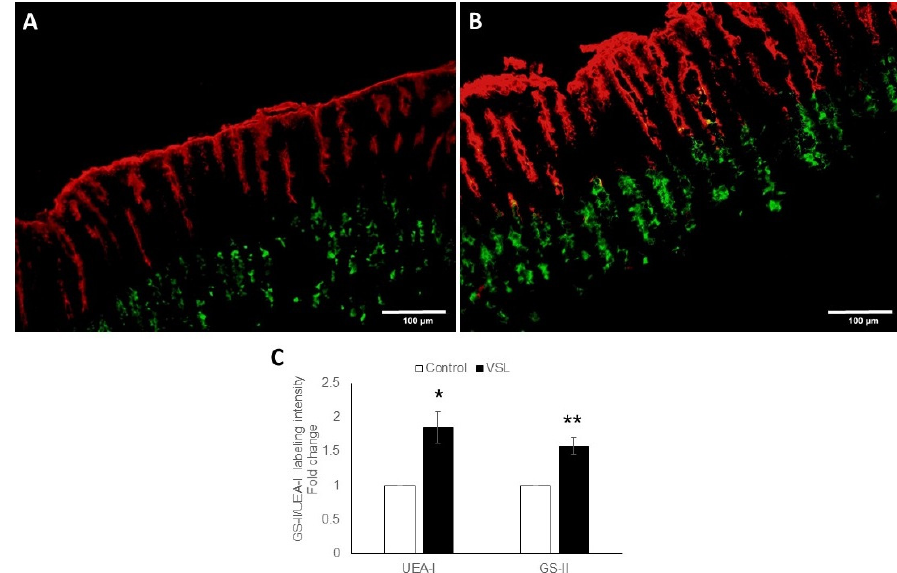
Figure 2. Double lectin histochemistry of the gastric mucosae of control and VSL-treated tissues. Stomach tissue sections of control ( A ) and VSL-treated ( B ) mice were incubated with UEA-I (red) and GS-II (green). Images obtained with 20× objective lense, scale bar: 100 µm. Fold changes in the quantification of the UEA-I and GS-II labeling intensity of control ( n = 7) and VSL-treated ( n = 7) tissues ( C ) are presented as mean ± SE. The asterisks indicate significant differences from the control group. * p < 0.05, ** p < 0.01. Int. J. Mol. Sci. 2019 , 20 , x FOR PEER REVIEW